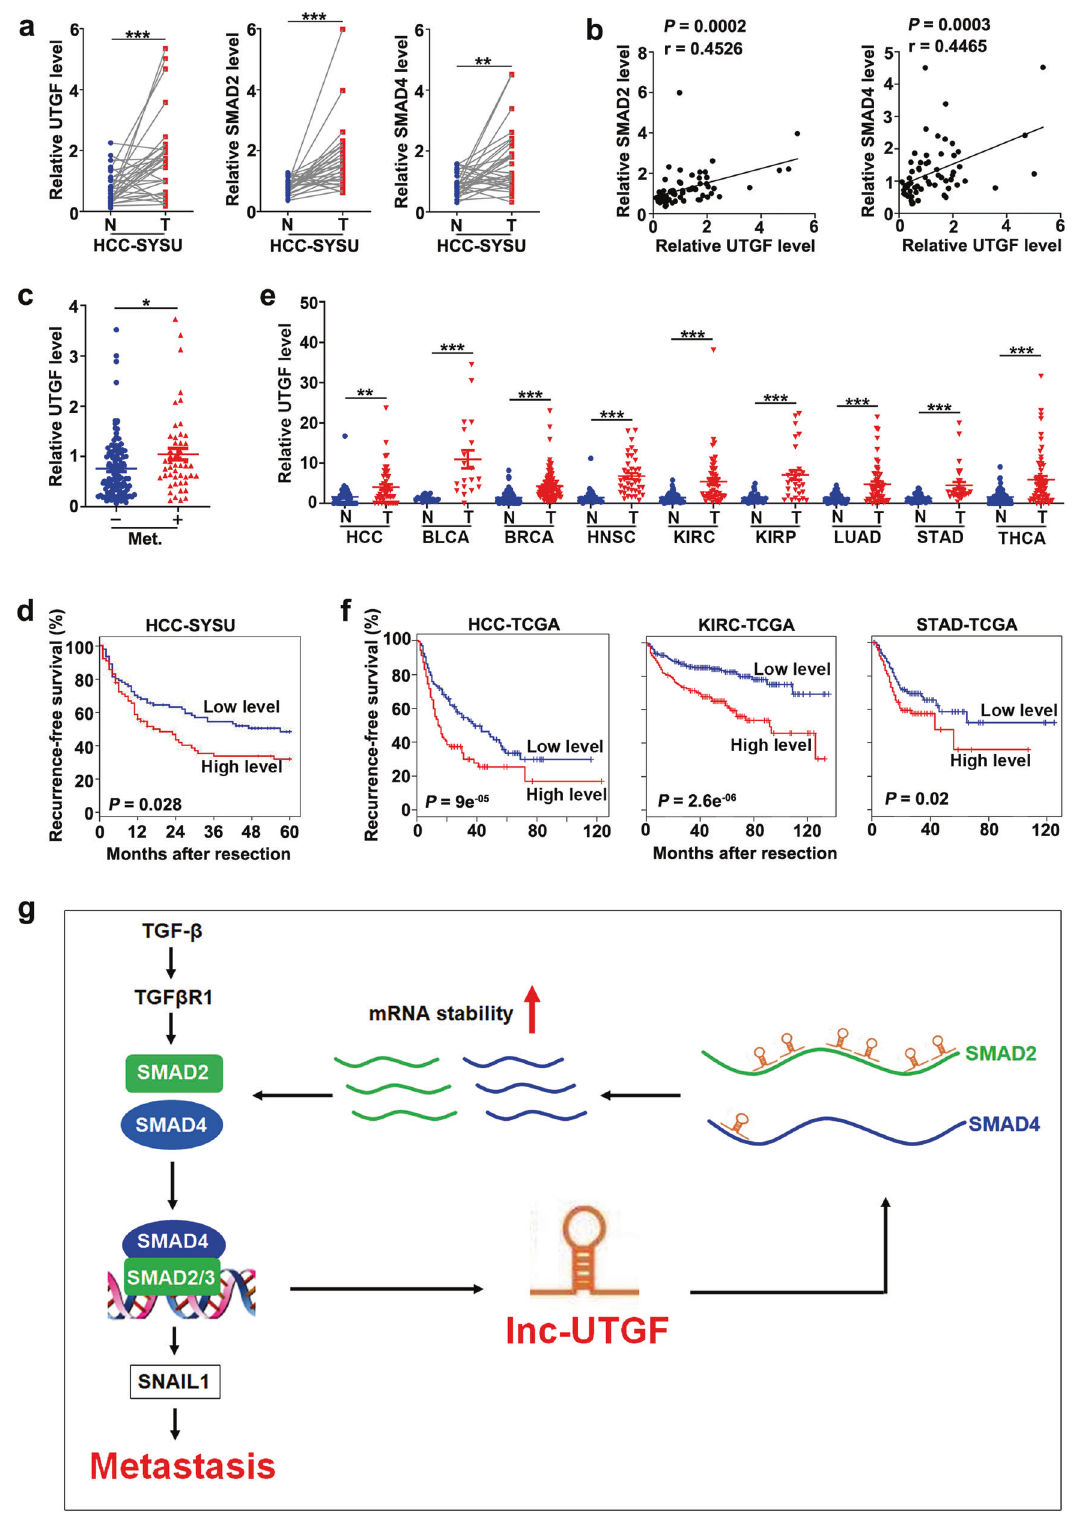
In vitro cell proliferation and apoptosis assays . Cell counting and colony formation assays were used to access the in vitro proliferation of tumor cells. Nuclear morphological examination by DAPI staining was used to evaluate the apoptosis of tumor